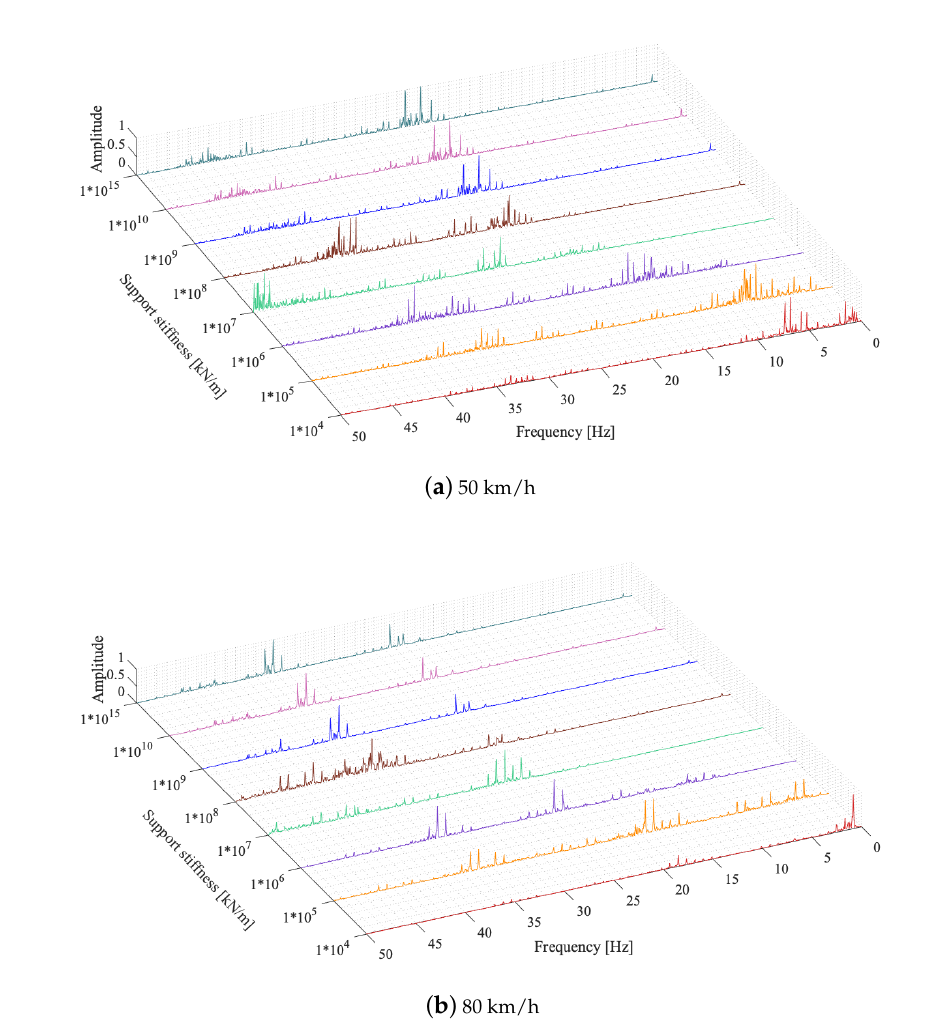
Figure 16. Fourier Amplitude Spectrum of the accelerations at the middle of the second span for the three-span bridge. Different colors correspond to different bearing stiffness